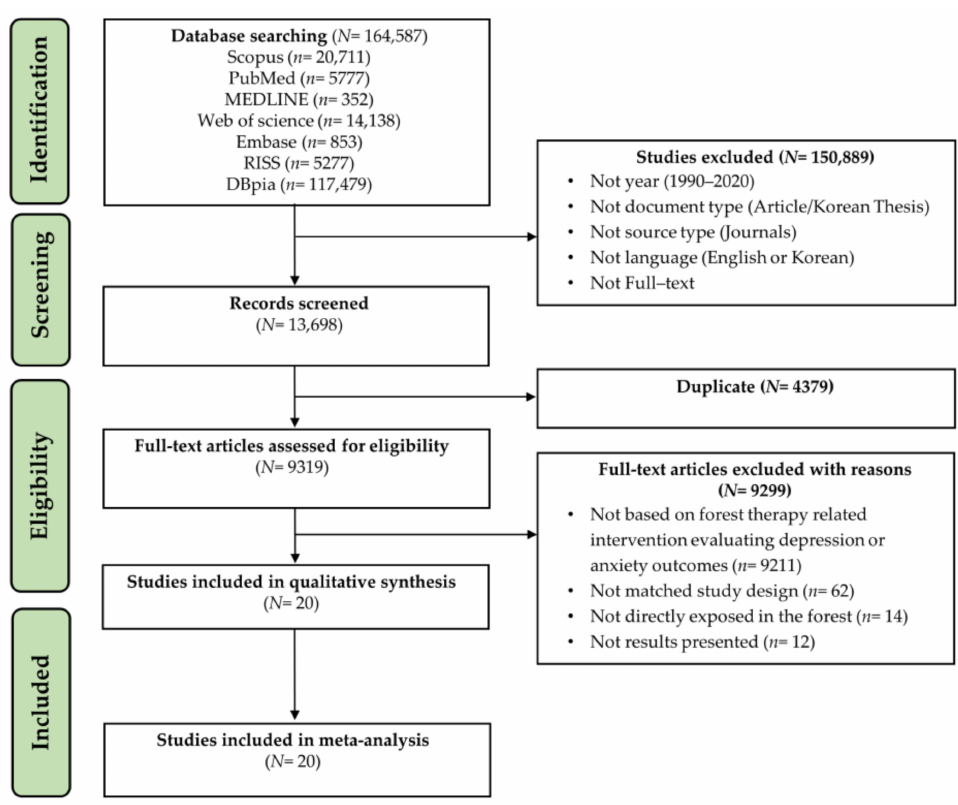
Figure 2. PRISMA flow chart of study